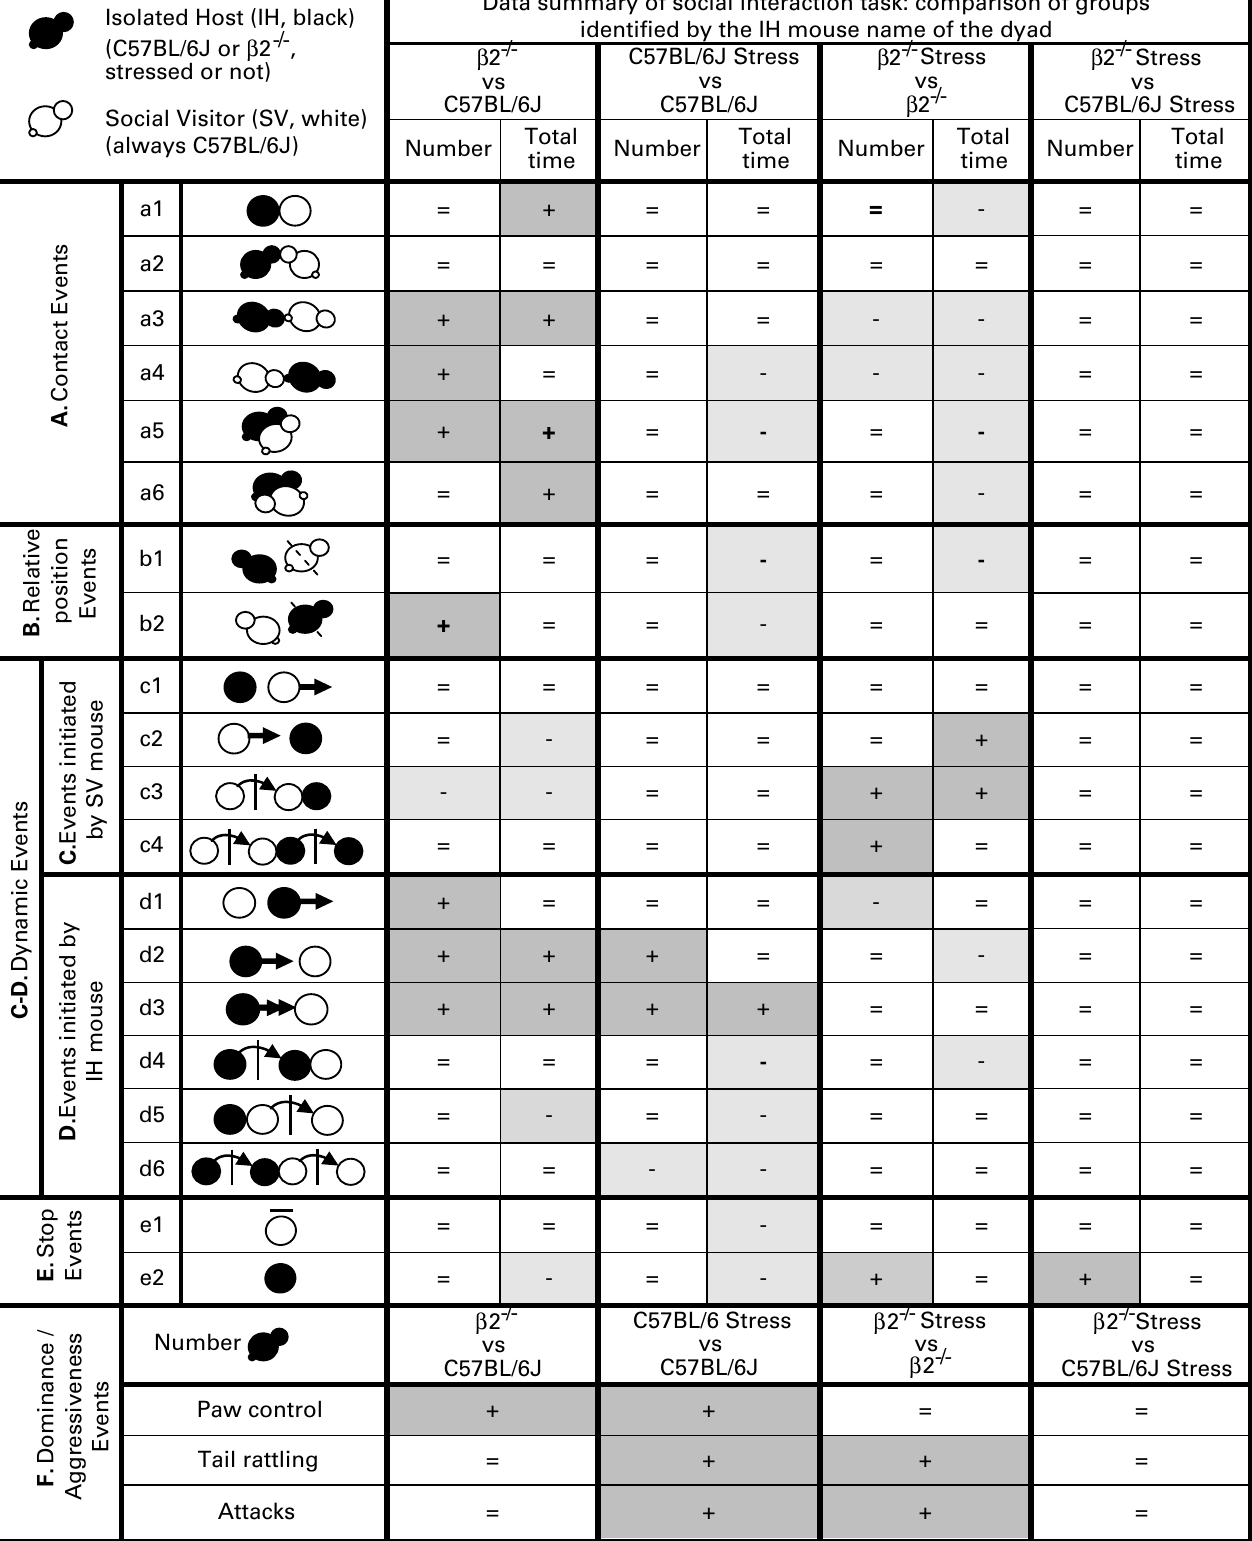
Data summary of social interaction task: comparison of groups identified by the IH mouse name of the dyad β